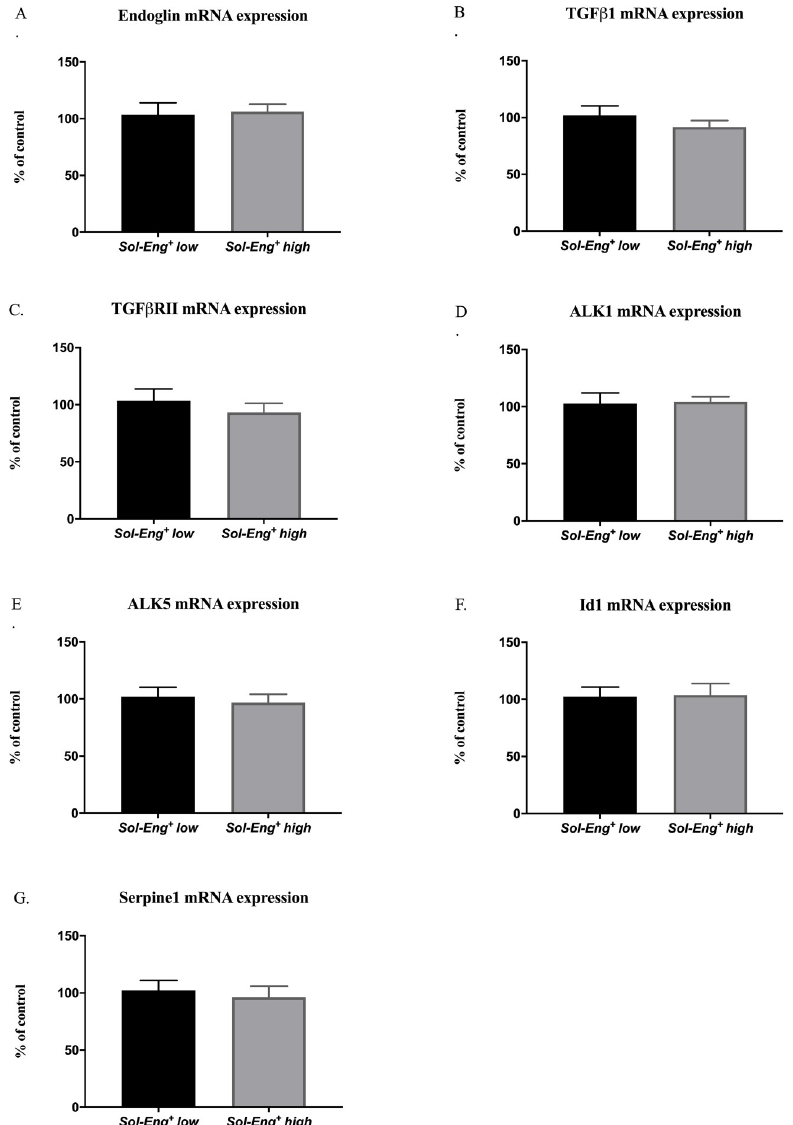
Fig 3. TGF β signaling pathway in the hearts of Sol-Eng + mice. mRNA expression of membrane Eng (A), TGF β 1 (B), TGF β RII (C), ALK1 (D), ALK5 (E), Id1 (F) and Serpine1 (G). Data are shown as mean ± S.E.M., Mann-Whitney test. n = 7 mice per